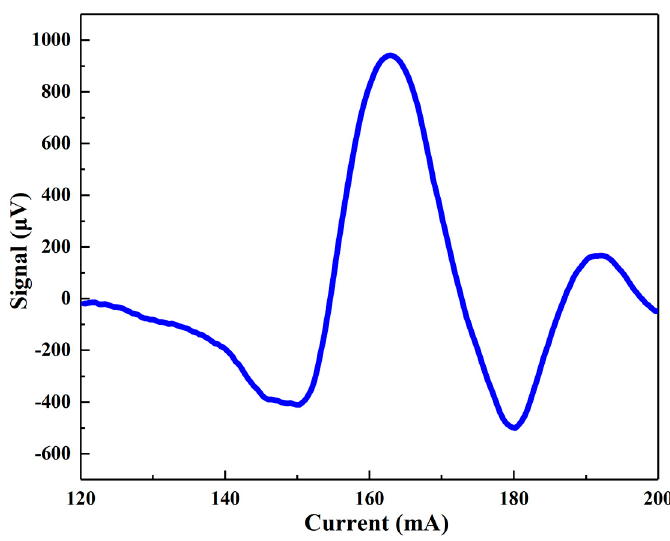
Figure 6. 2f WMS PAS signal scan of the H 2 S absorption line in a sewer gas sample. The experiment was carried out at atmospheric pressure and room temperature. The modulation depth and excitation light power were 30 mA and 1.4 W, respectively.